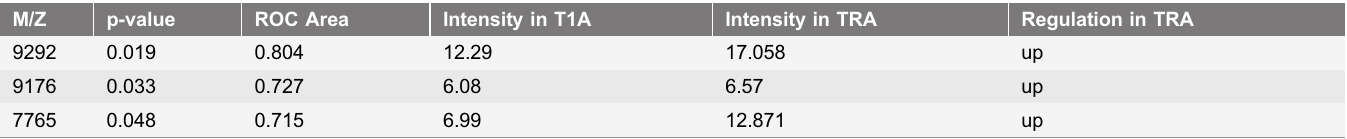
Table 3. Differential expression among vemurafenib treated patients; in all patients who achieved a response 3 peptides resulted significantly up-regulated at response evaluation: m/z 9292, 7765 and 9176. M/Z p-value ROC Area Intensity in T1A Intensity in